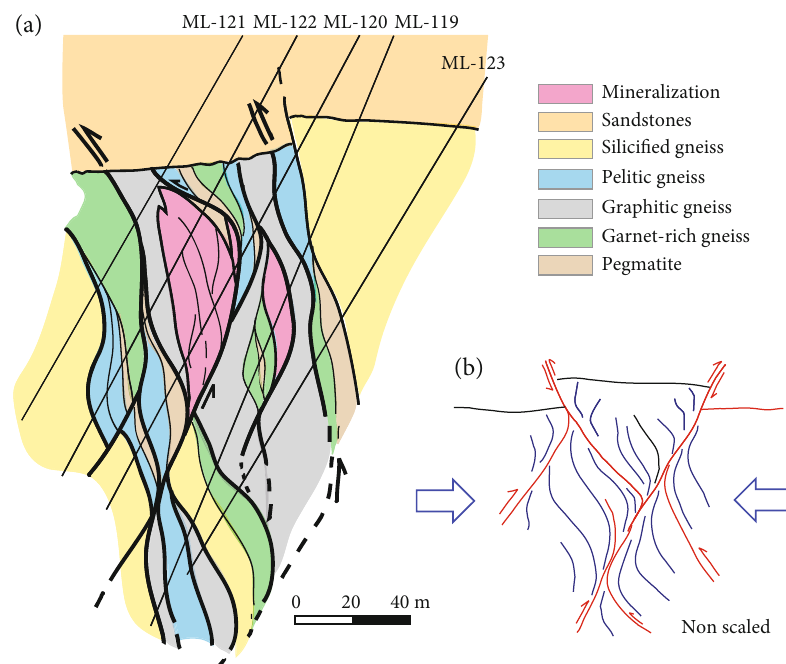
Figure 13: Cross section b (Figure 9(b)) through holes ML-121 to ML-123 revisited taking into account the conjugated symmetric shear zone 7 pattern attributed to coaxial